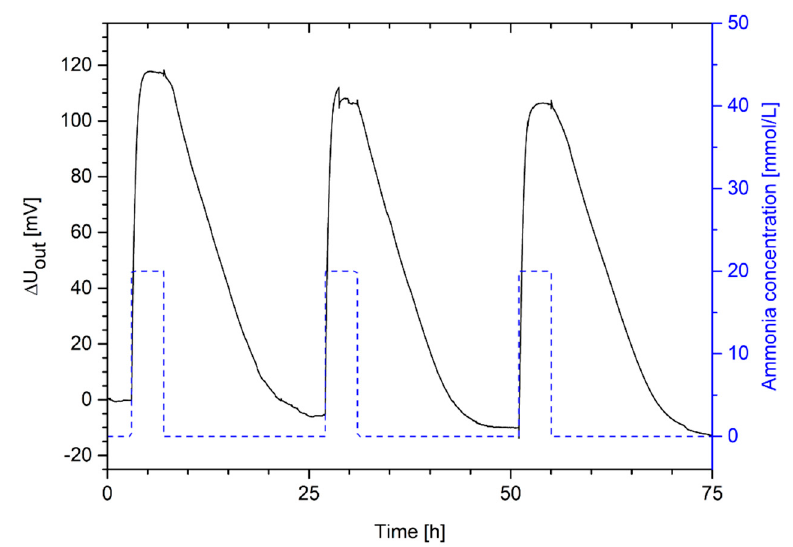
Figure 7. Change in output voltage of a hydrogel pressure sensor based on poly(AAc ‐ co ‐ DMAEMA) (60 mol% AAc, 40 mol% DMAEMA) for cyclic changes of ammonia concentrations in PBS buffer between 20 mmol/L and 0 mmol/L.